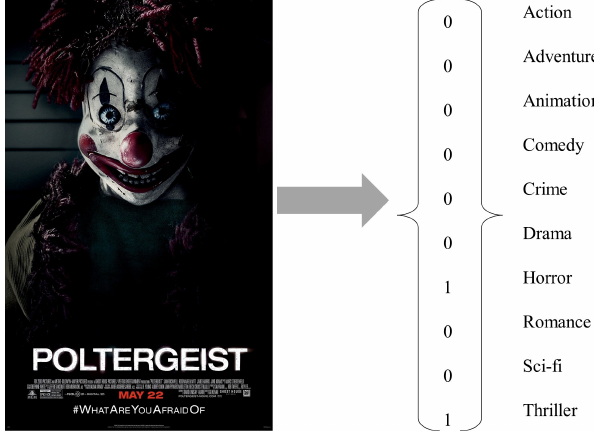
Figure 6. Sample of movie genres labeled as multi- hot